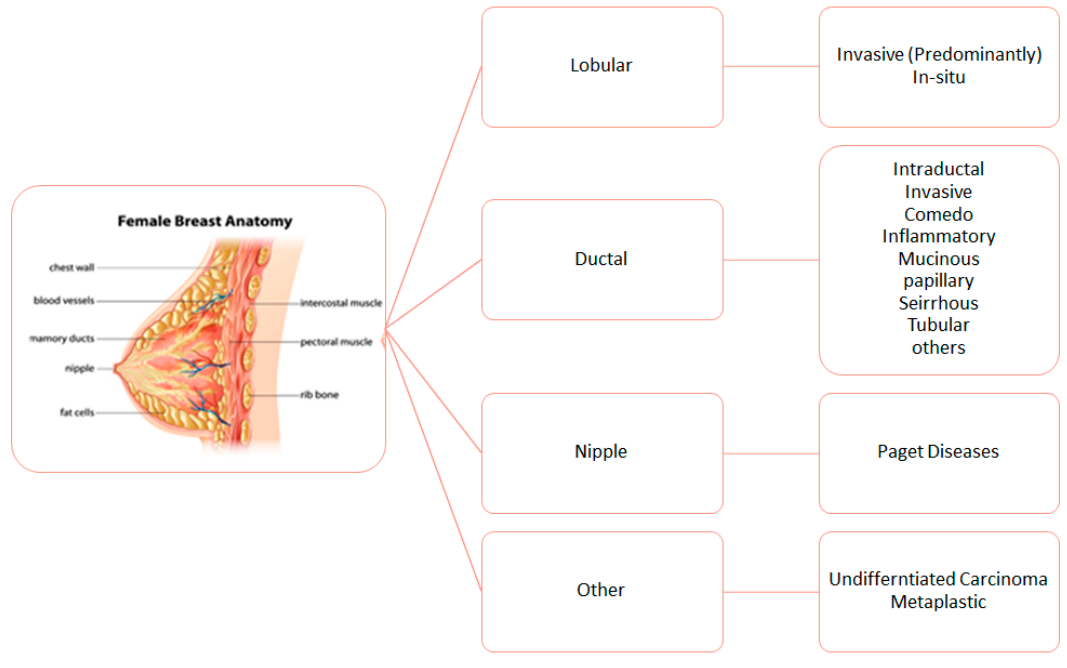
Figure 3. Diseases of the breast tissue and their origins.[18].